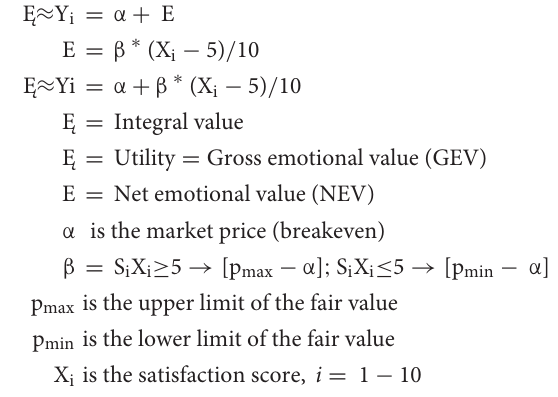
the individuals overall. The indicated regression is reflected in Figure 8